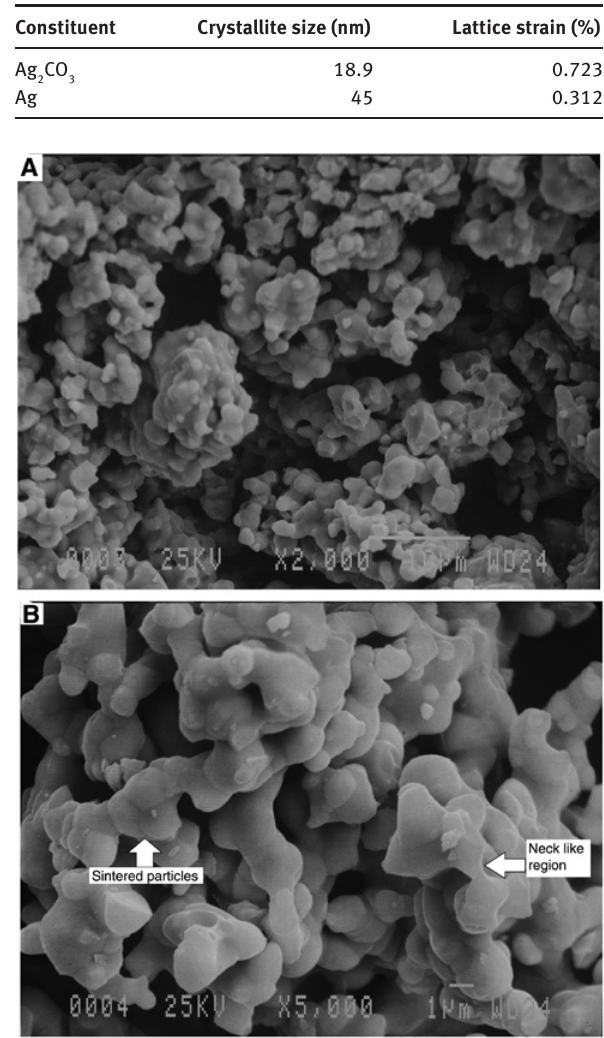
Table 1: Crystallite size and microstrain of Ag and Ag